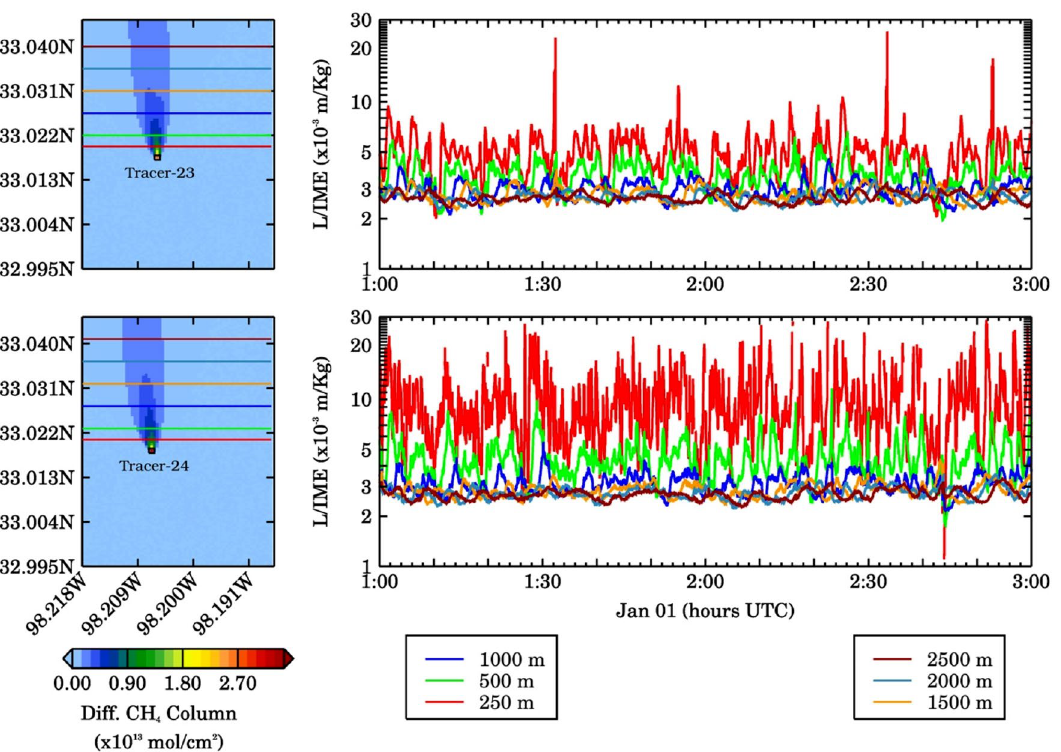
Figure 4. (Left) Spatial distribution of averaged methane column for constant emission sources (tracers 23, top; 24, bottom) over the model domain. The solid-colored lines represent 6 different intersections at 250, 500, 1000, 1500, 2000, and 2500 m downwind of the methane plume. (Right) Ratio of effective plume length to IME for Tracer-23 (top-right) and Tracer-24 (bottom-right),